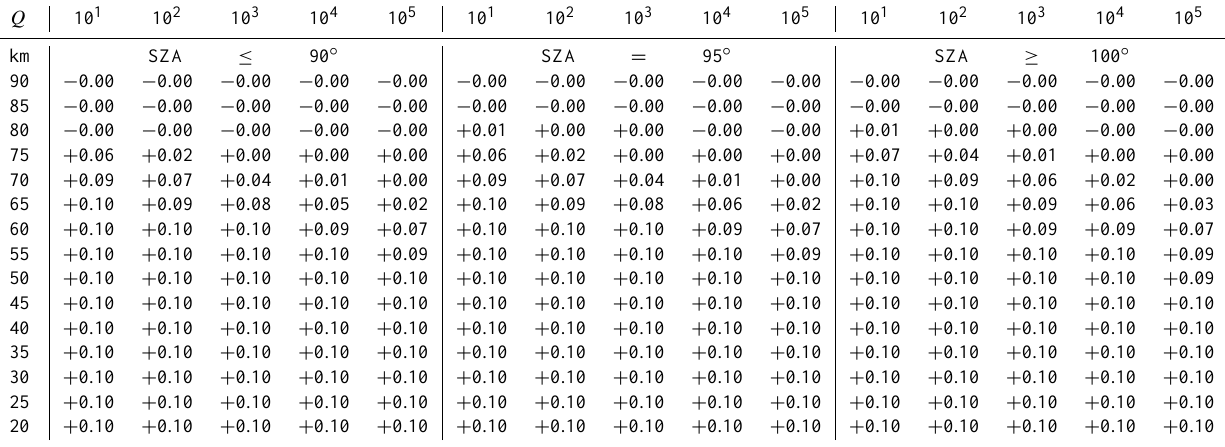
/Q for October NH. 2